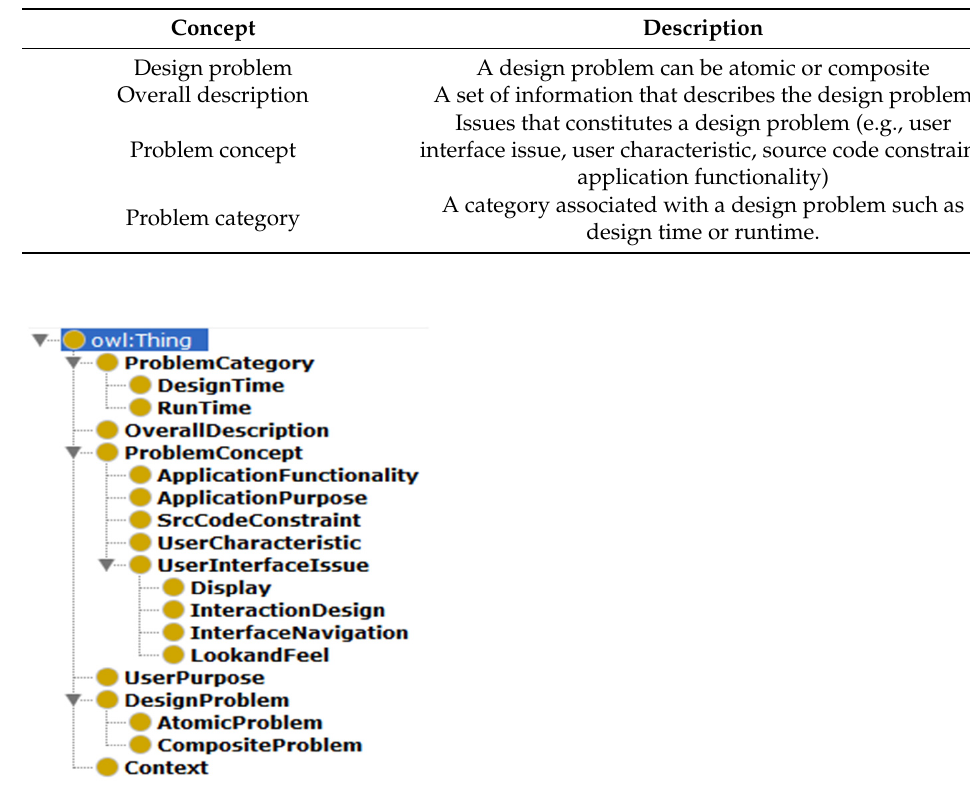
Figure 2. Design problem ontology model within Protégé.